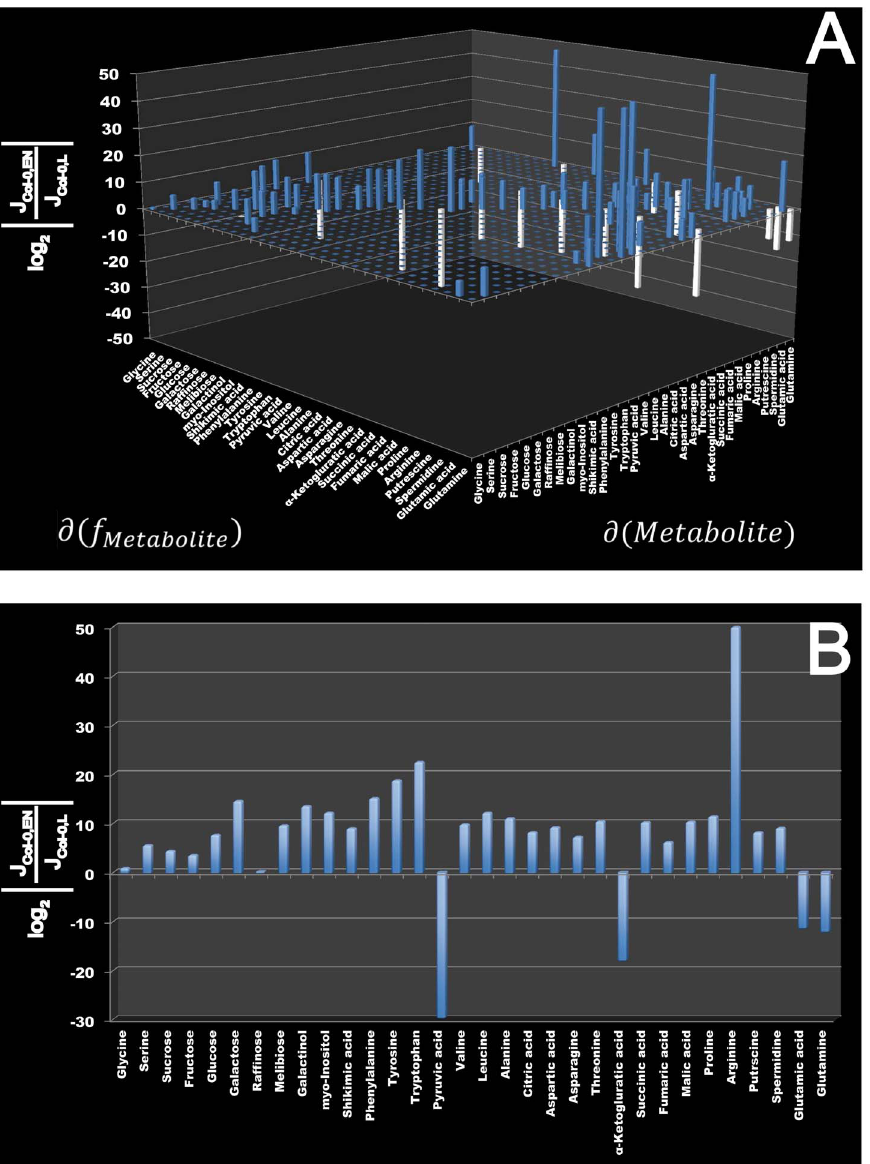
Figure 2. Differential Jacobian of Col-0 under conditions of light and extended night. Bars represent the log 2 -ratio of the entries in the Jacobian matrices of Col-0 under conditions of light (L) and extended night (EN), which were derived from covariance data of metabolomics data sets. Blue colour indicates a ratio . 1, i.e. the Jacobian entry of the samples of extended night was higher than under normal light. White colour indicates a ratio , 1, i.e. the Jacobian entry of the samples of extended night was lower than under normal light. All entries represent median values of 10 3 calculations normalised to the square of interquartile distance. ( A ) L ( f Metabolite ) and L ( Metabolite ) characterize the entries of the Jacobian matrix and refer to equation 1. ( B ) shows the diagonal entries of the Jacobian matrix belonging to the metabolites described on the horizontal